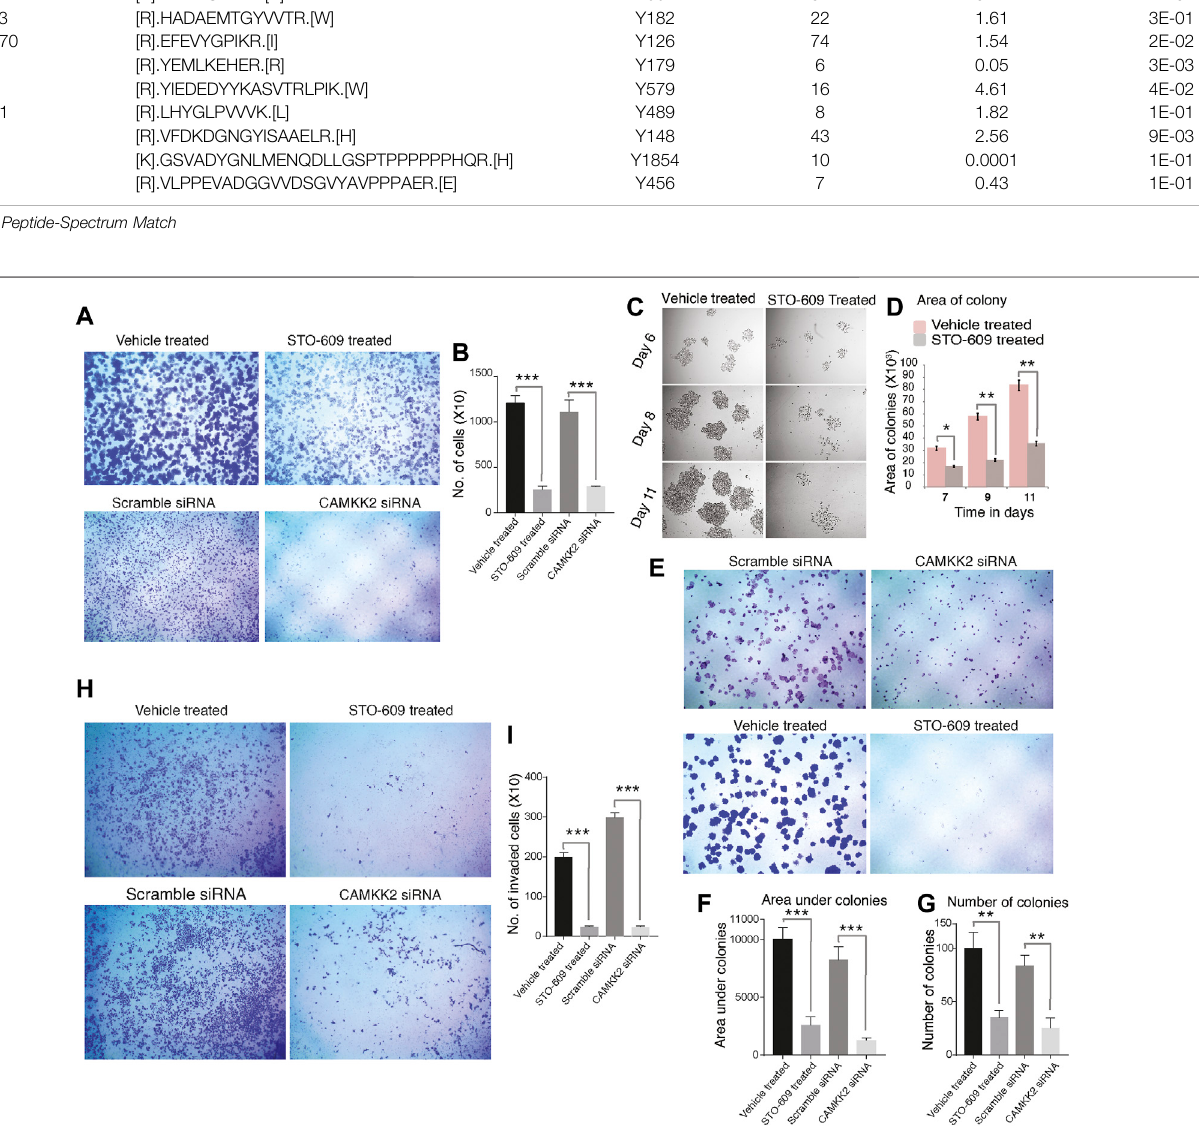
Frontiers in Genetics |